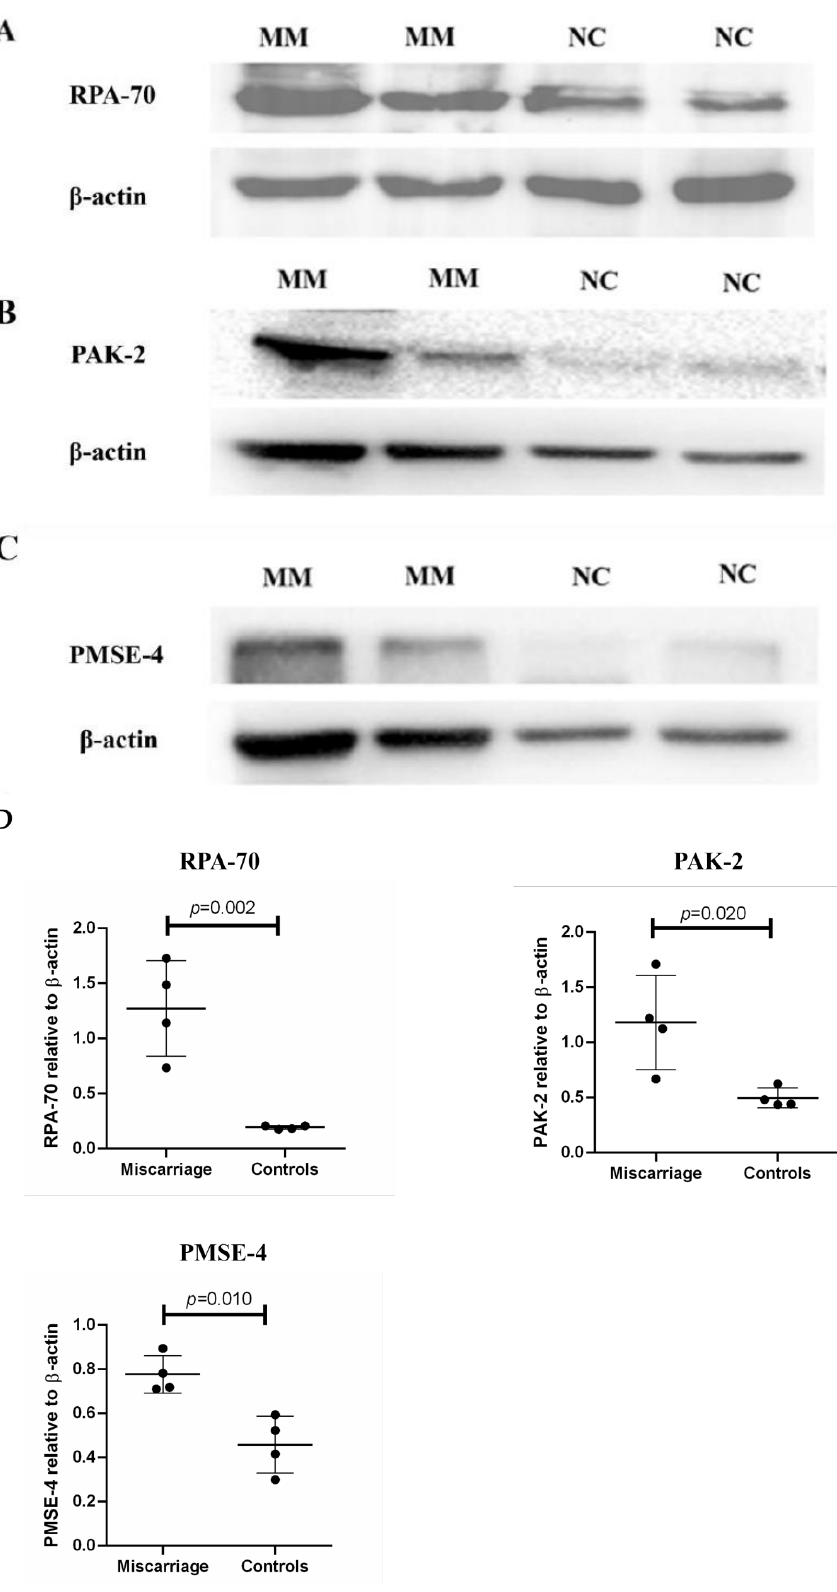
Figure 5. The representative western blotting images showing the high levels of RPA-70 ( A ) and PAK-2 ( B ) in placental micro-EVs, and high levels of PSME-4 ( C ) placental nano-EVs derived from missed-miscarriage placentae, measured by a semiquantitative analysis ( D ). (MM: missed miscar- riage, NC: control).